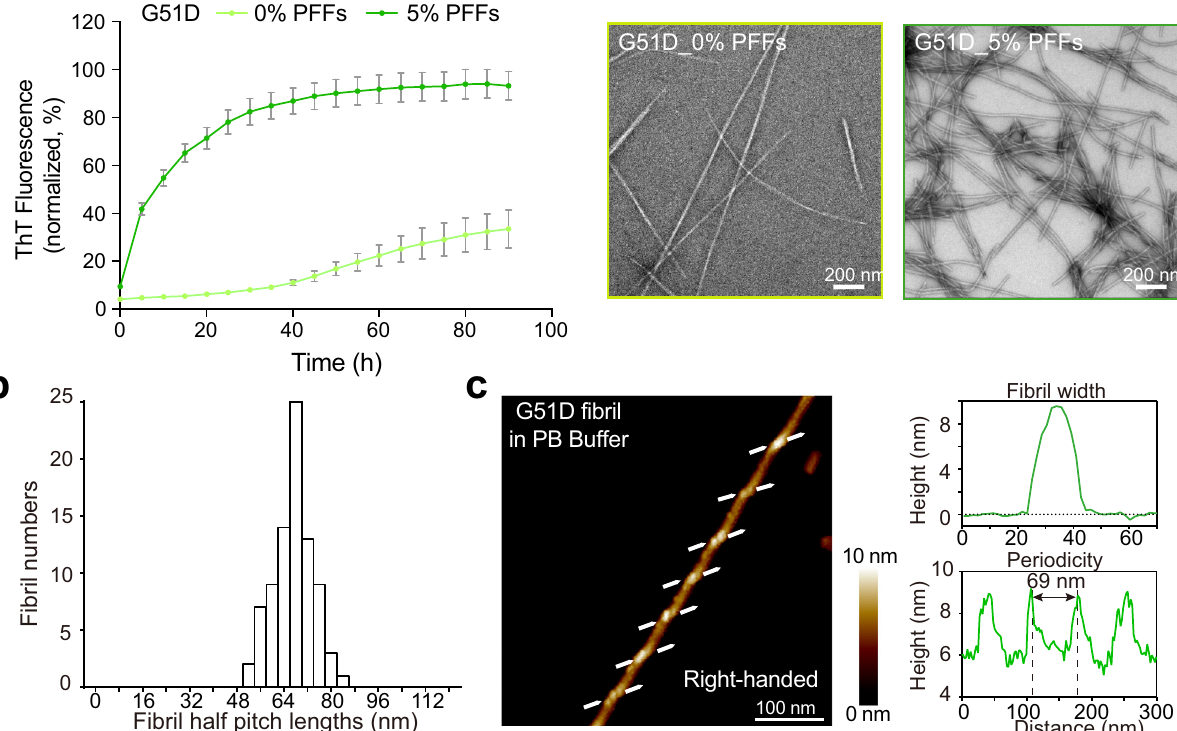
Fig. 1 Characterization of the fi brils formed by G51D α -syn. a ThT kinetic assay of the G51D fi bril formation with (colored in dark green) and without PFFs (5 mol%) (colored in light green) in PB Buffer (50 mM phosphate buffer, pH 7.0, 50 mM NaCl). Data are shown as mean ± s.d., n = 5 independent samples (left panel). The fi brils formed at the endpoint of the ThT kinetic assay were characterized by NS-TEM (right panel). Scale bar: 200 nm. b Histogram of half-pitch lengths of G51D fi brils (0% PFFs) measured from NS-TEM images ( n = 83). c AFM image of a G51D fi bril. The arrows at both sides of the fi bril indicate the starting points of the fi bril protrusions to clarify the handedness. Images were acquired with a 1.45 Hz rate at 512 × 512 pixels. Fibrils formed by G51D in >3 independent experiments provide reproducible images. The fi bril width and periodicity were analyzed by the Nanoscope